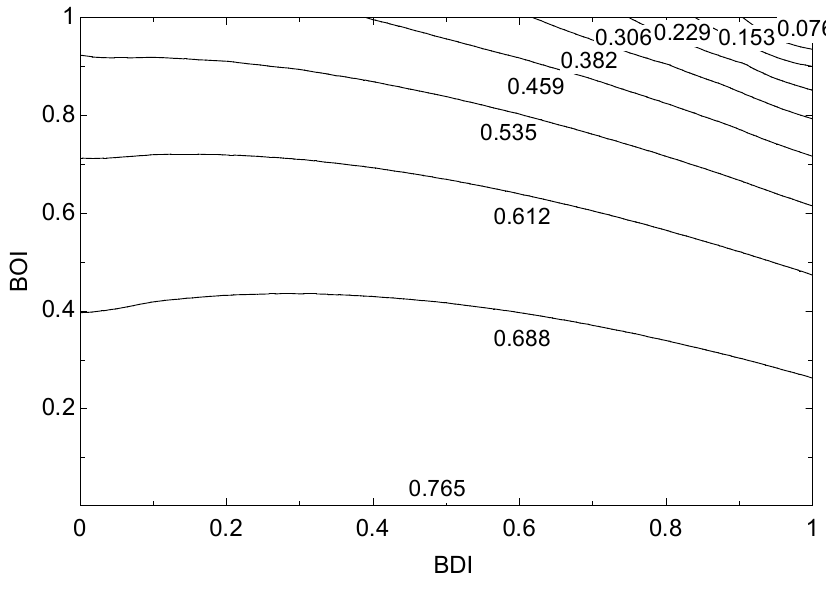
Figure 7. Maximum building energy saving potential, ESPm.